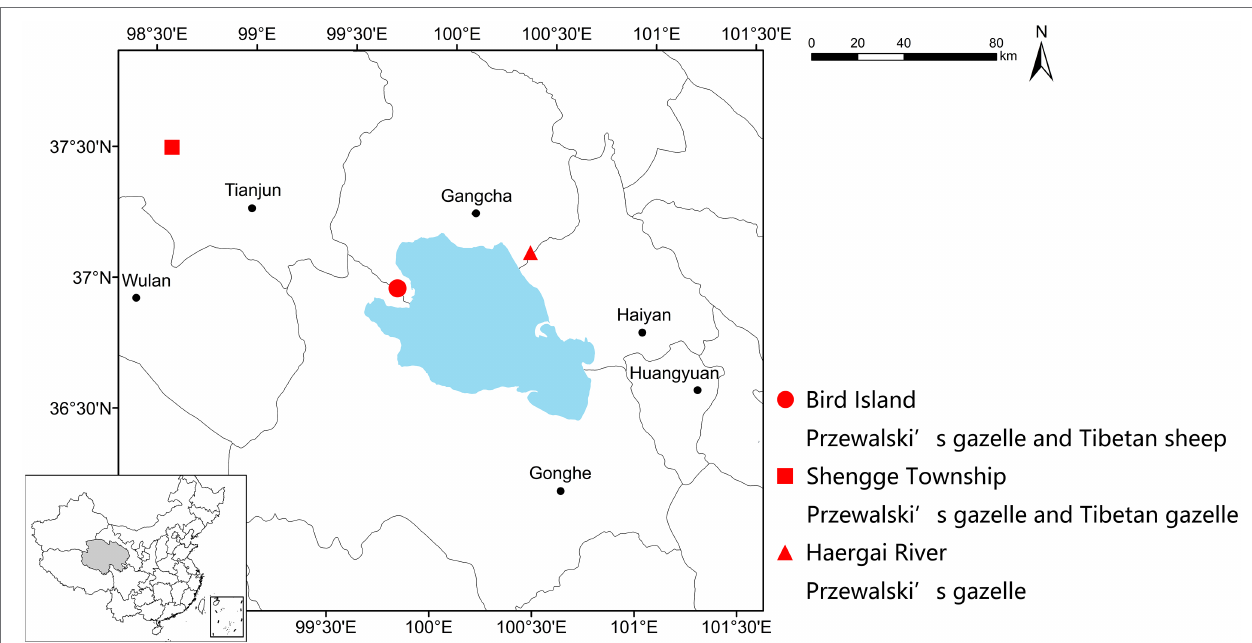
FIGURE 1 | Geographic locations of sample collection sites. This study included one managed Przewalski’s gazelle population sympatric with Tibetan sheep (Bird Island, red dot), one wild Przewalski’s gazelle population sympatric with Tibetan gazelle (Shengge Township, red square), and one wild Przewalski’s gazelle population with no sympatric ruminants (Haergai River, red triangle).